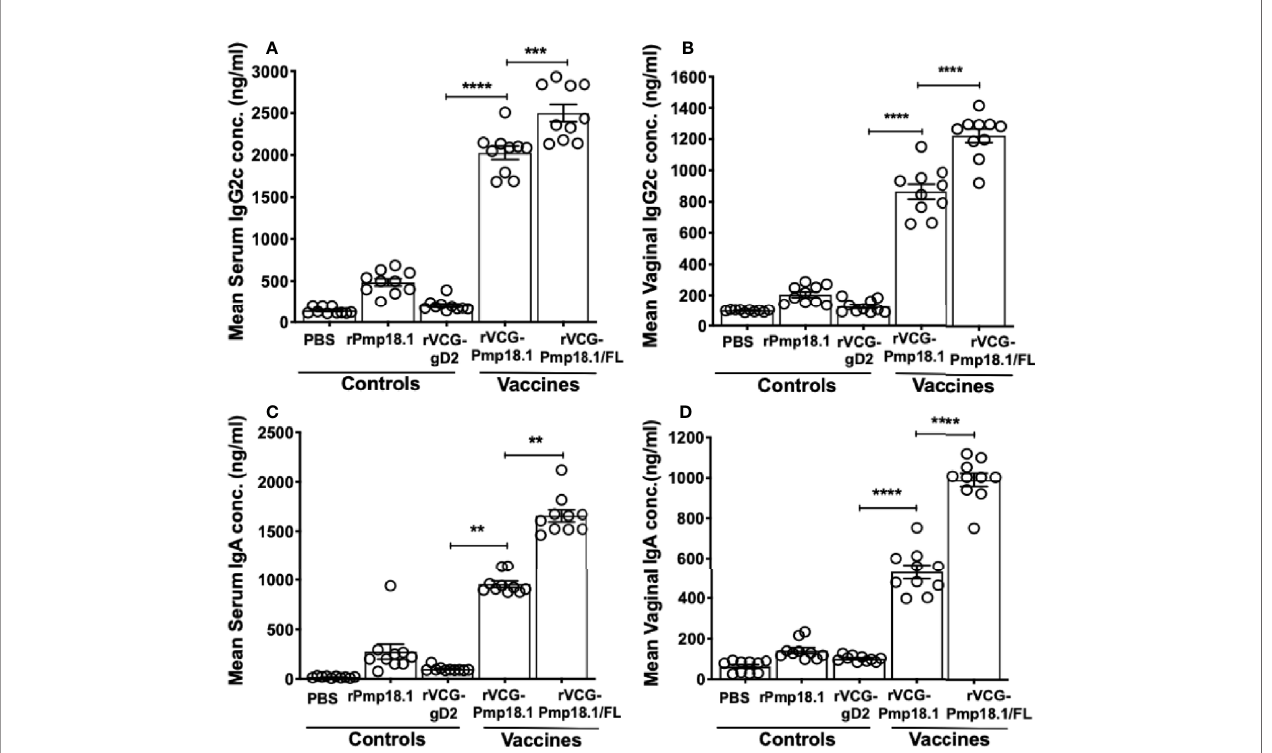
FIGURE 3 | Antigen-speci fi c IgG2c and IgA antibody responses induced in serum and vaginal wash samples. Groups of mice were immunized IN three times, 2 weeks apart. Serum and vaginal lavage samples were obtained from individual mice in each group 2 weeks after the last immunization. ELISA procedure was used to assess the concentration of IgG2c and IgA antibodies elicited in serum (A – C) and vaginal lavage (B – D) samples. The results were generated simultaneously with a standard curve and display data sets corresponding to absorbance values as mean concentrations (ng/ml) ± SD of triplicate wells for each experiment. The results are a representative of two independent experiments with similar results. Signi fi cant differences between groups were evaluated by One-way ANOVA with Tukey ’ s post multiple comparison test at p ** < 0.01, p *** < 0.001 and p **** <